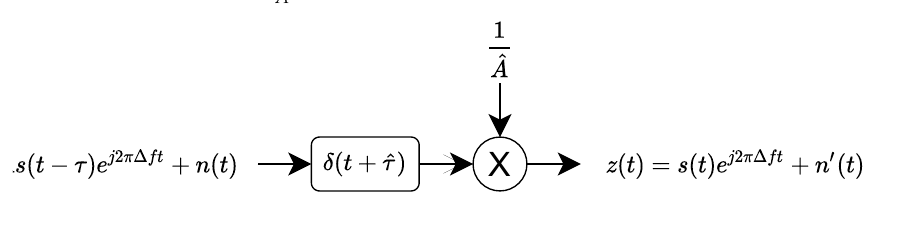
Figure 4. Preprocessing process